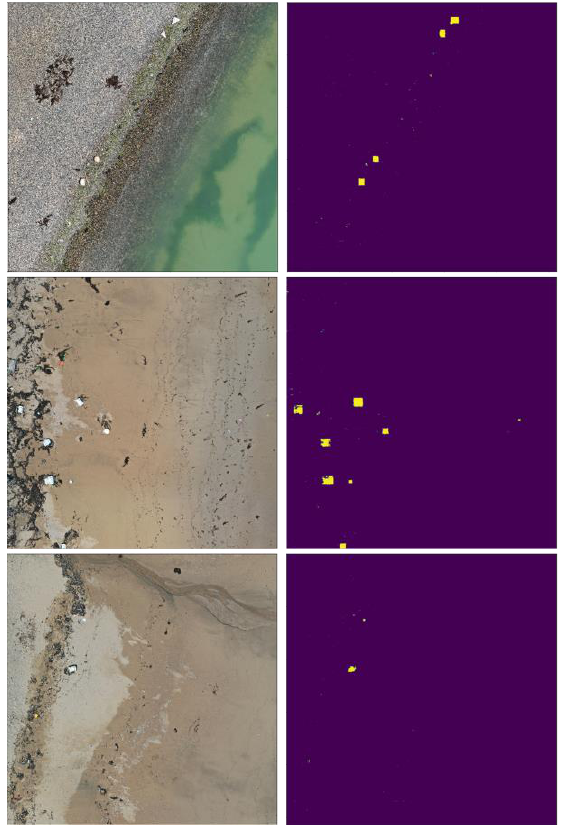
Figure 5. Styrofoam detection result from deep neural network(left : input image, right : detection